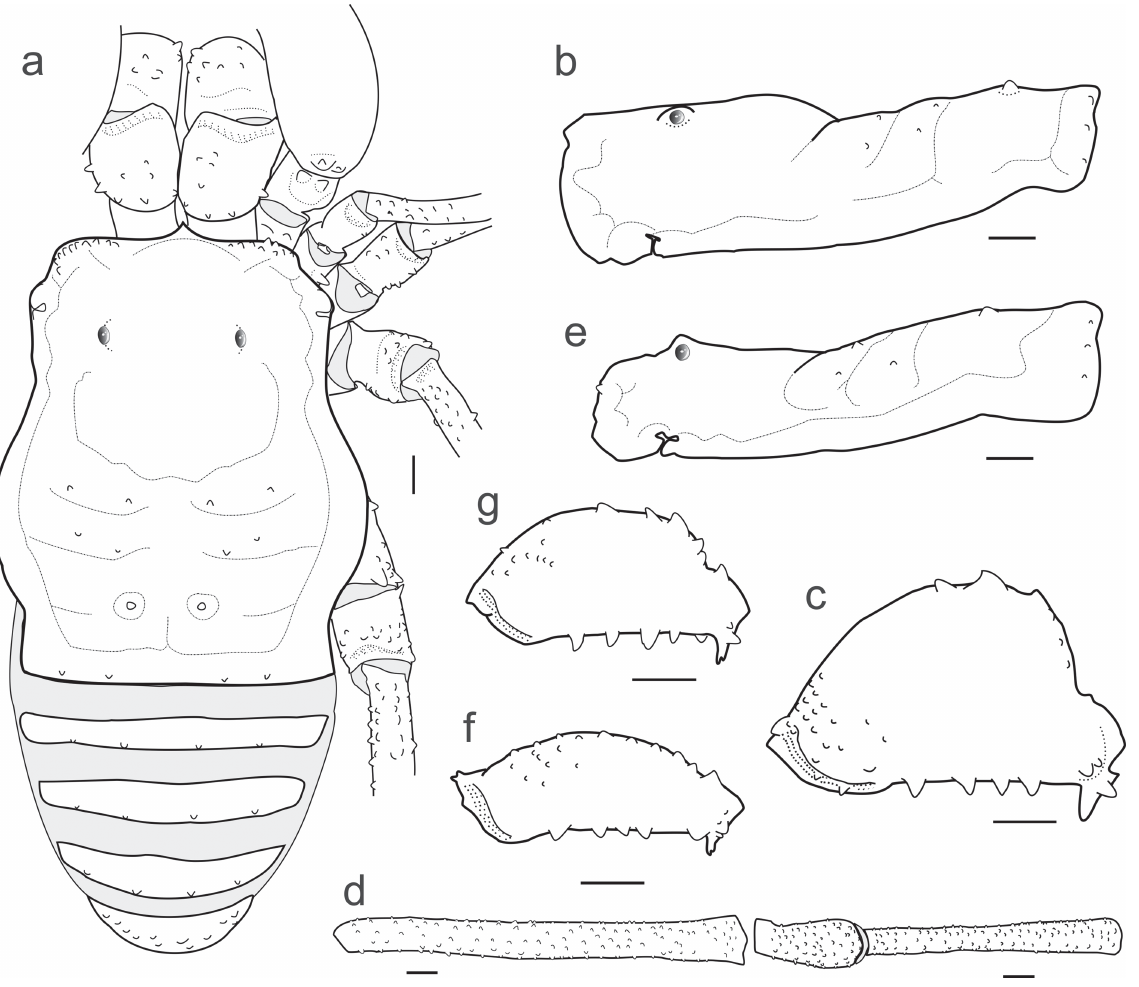
Fig. 14. Phalangodus kuryi sp. nov. a–d . Holotype, ♂ (ICN-AO-1436). e–f . Paratype, ♀